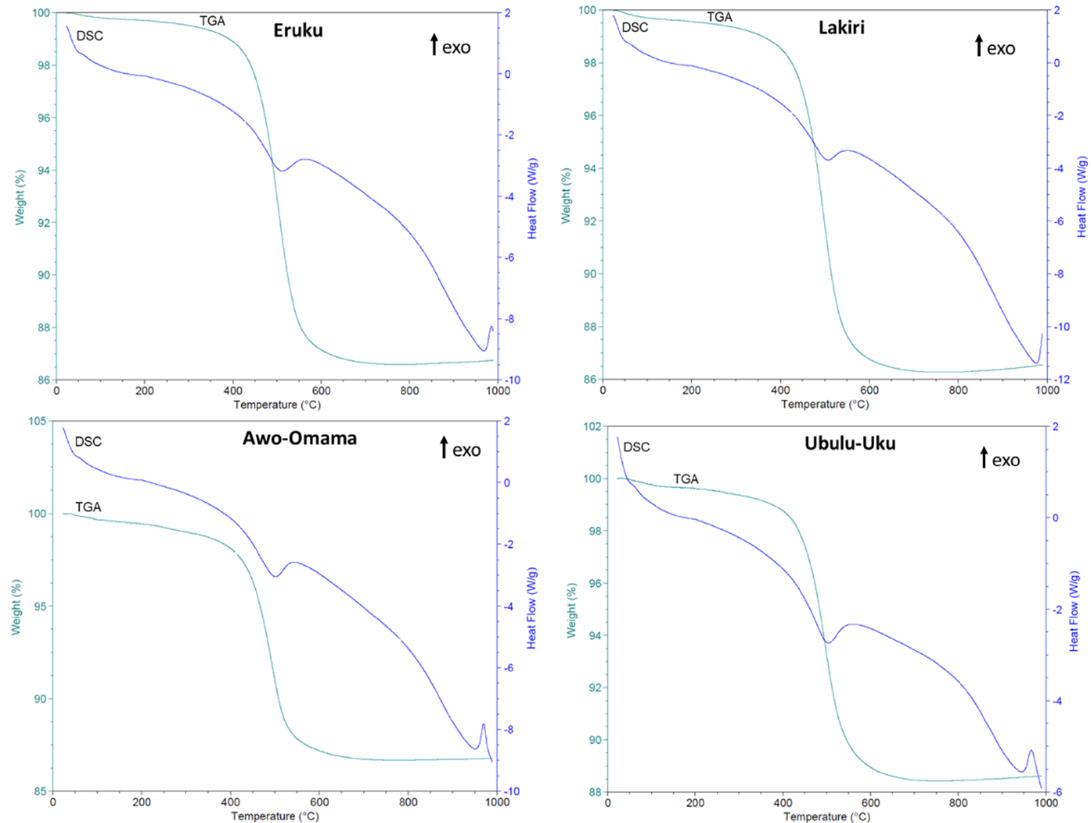
Figure 5. Representative thermogravimetric analysis and differential scanning calorimetry (TGA/DSC) curves of the samples of the studied kaolin deposits with the highest kaolinite contents.